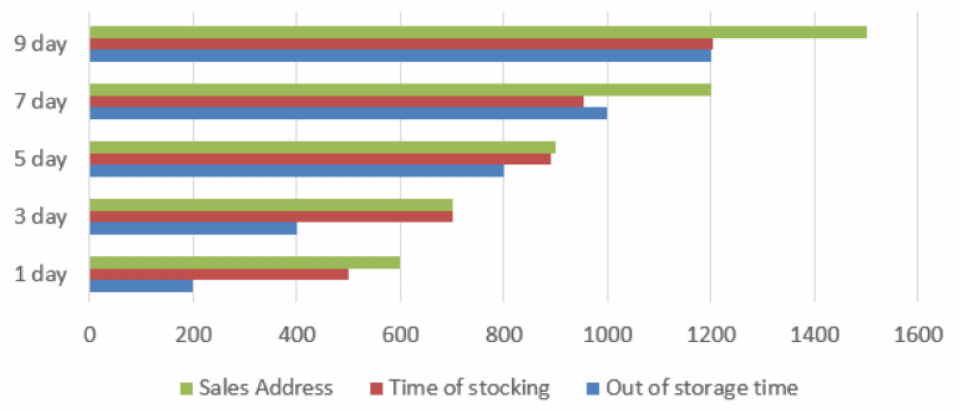
Figure 9. Statistics of the number of